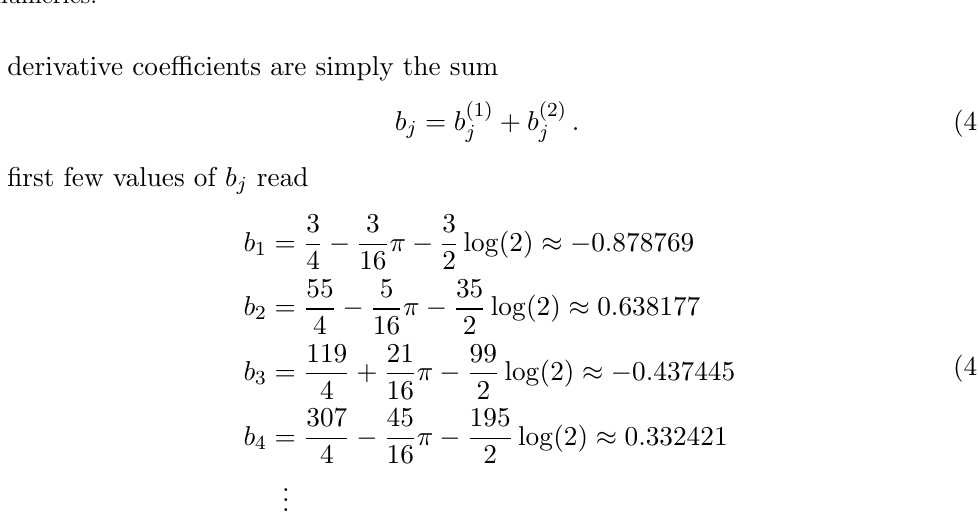
Figure 8 . Comparison of the analytic extremal functional in the derivative basis (4.43) (dashed lines) and the numerical bootstrap extremal functionals (dots) for (cid:1) = 1 = 2. b j is the coe(cid:14)cient of the y -derivative of order 2 j 1 and N max is the order of the maximal z -derivative used in (cid:0) the